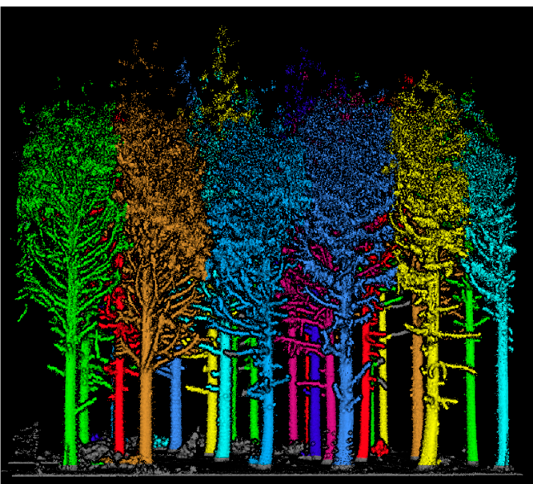
Figure 4. Tree extraction using LiDAR360 software.